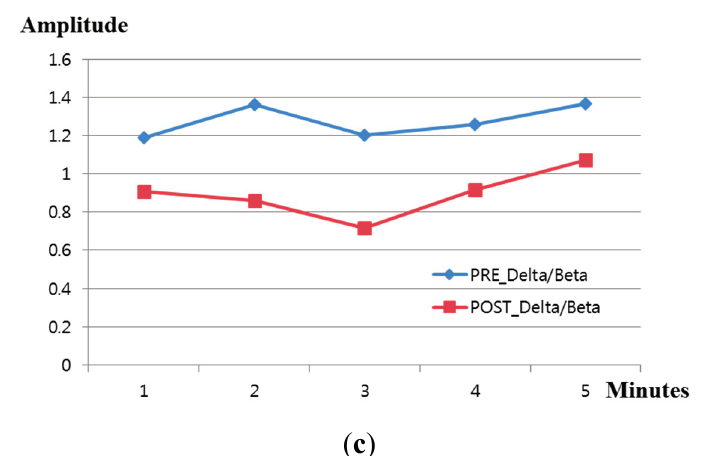
Figure 8. Comparison of delta and beta waves before and after watching a horror movie.